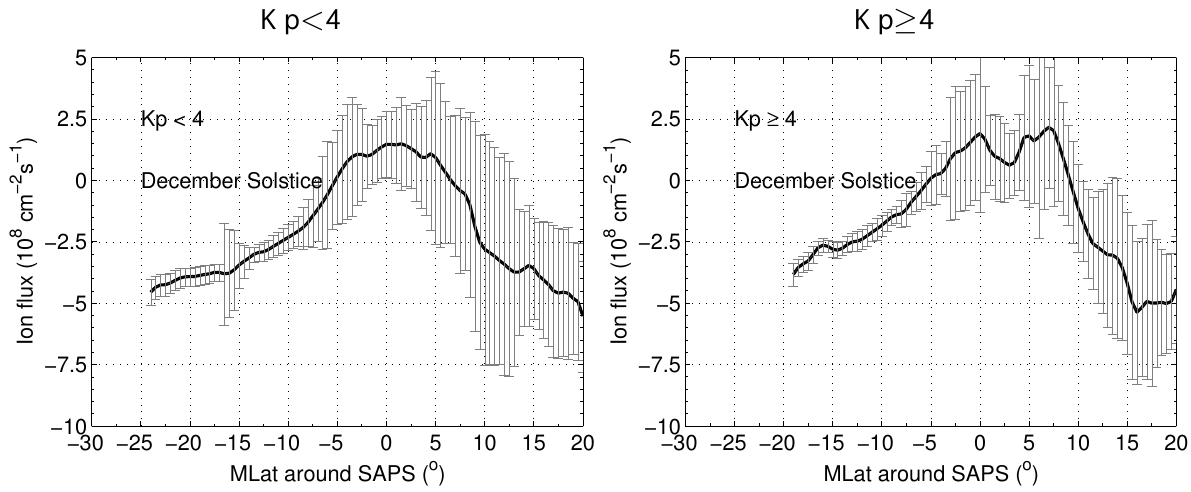
Fig. 9. Superposed epoch analysis of the ion upflow flux in winter for two different Kp levels. The key MLat of “0” denotes the latitude where the SAPS velocity peak occurs. Positive denotes upward flux. The bars show the standard deviations of averages.